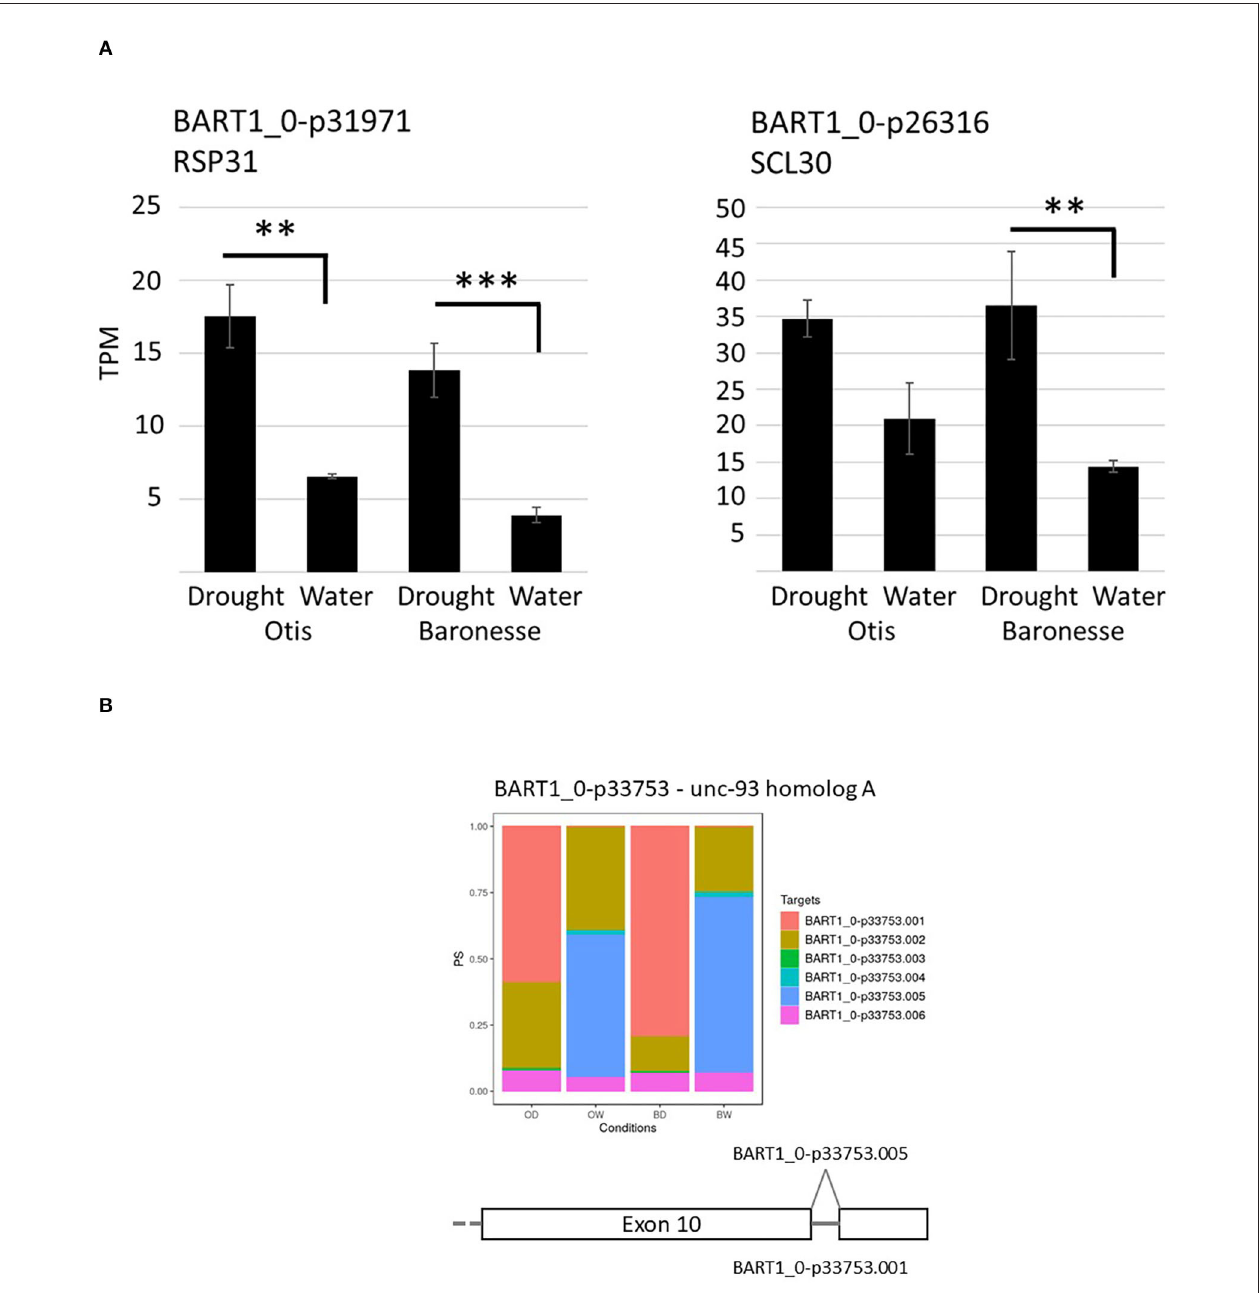
FIGURE 7 | Expression analysis of AS associated genes. (A) Mean differential gene expression of barley orthologs of SR splicing factors, RS31 and SCL30. Histograms show expression levels in transcripts per million (TPM) for watered and drought-treated Otis and Baronesse. Standard errors are the result of three biological repeats. Adjusted p values on log 2 FC: ** < 0.005; *** < 0.001. (B) Expression analysis of UNC93-A AS transcripts. Each gene transcript is represented by a different color. Each histogram bar represents an individual genotype under a specific condition. From left to right is Otis drought (OD), Otis watered (OW), Baronesse drought (BD) and Baronesse watered